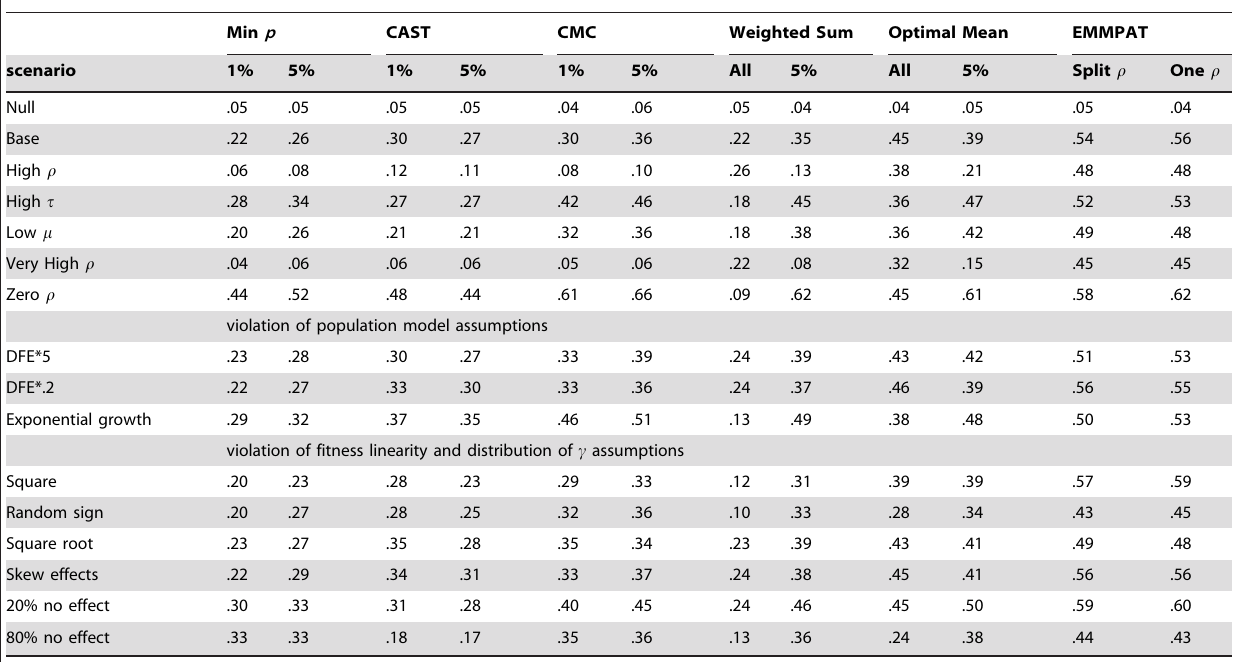
Table 4. Simulation study power